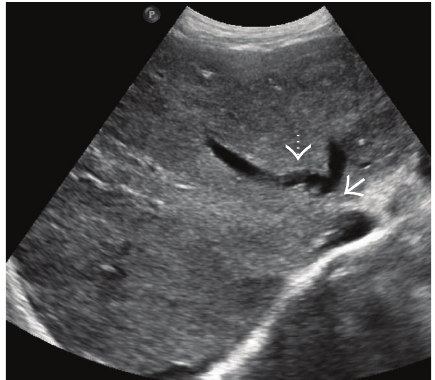
Figure 3: Gray-scale image from the US study of a patient with BCS due to obstruction of the common channel of the middle and the left hepatic veins (arrow) showing a more heterogeneous hepatic parenchymal echotexture. Collateral channel can be seen bridging the two hepatic veins proximal to obstruction (interrupted